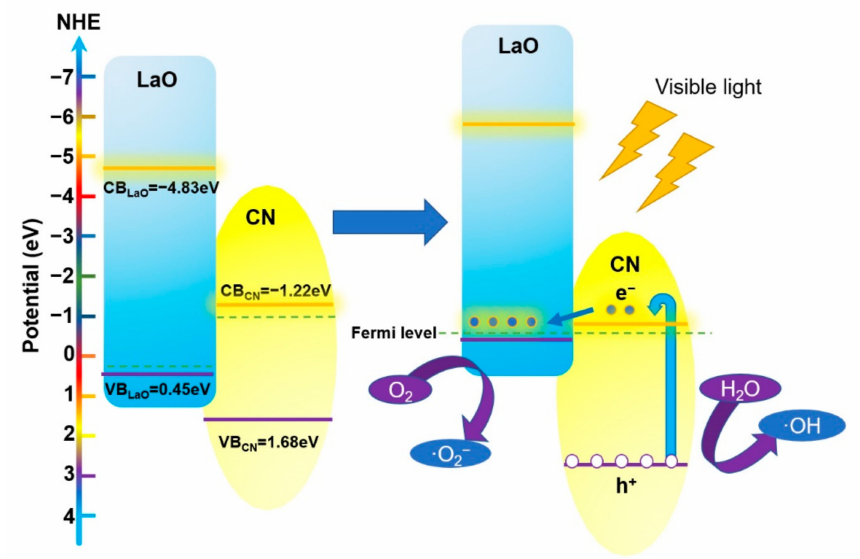
Figure 10. Possible mechanism of LaO/CN composite